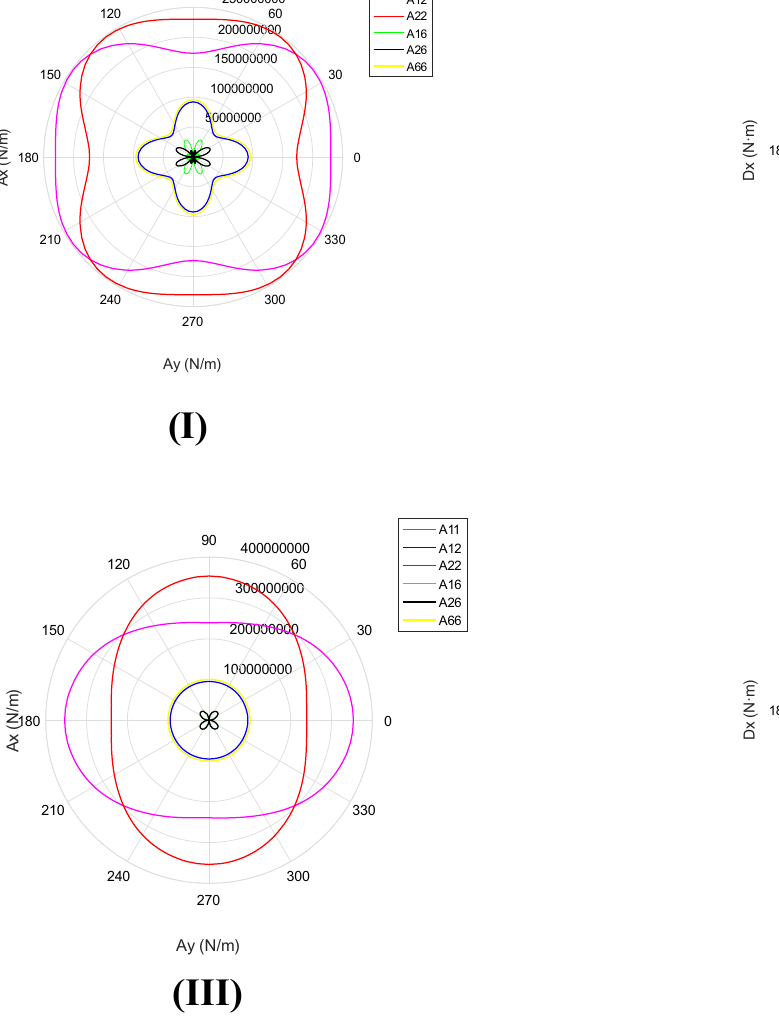
Figure 13: Tensile sti ff ness/bending sti ff ness parameters of web and reinforce web. ( I ) Web A ij . ( II ) Web D ij . ( III ) Reinforce web A ij . ( IV ) Reinforce web D ij